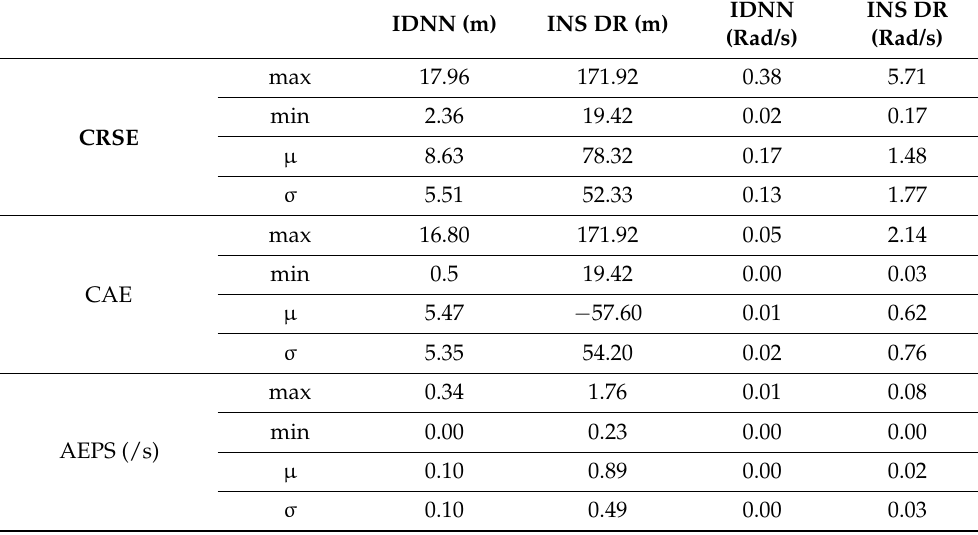
Table 9. Showing the performance of the IDNN and INS DR on the roundabout